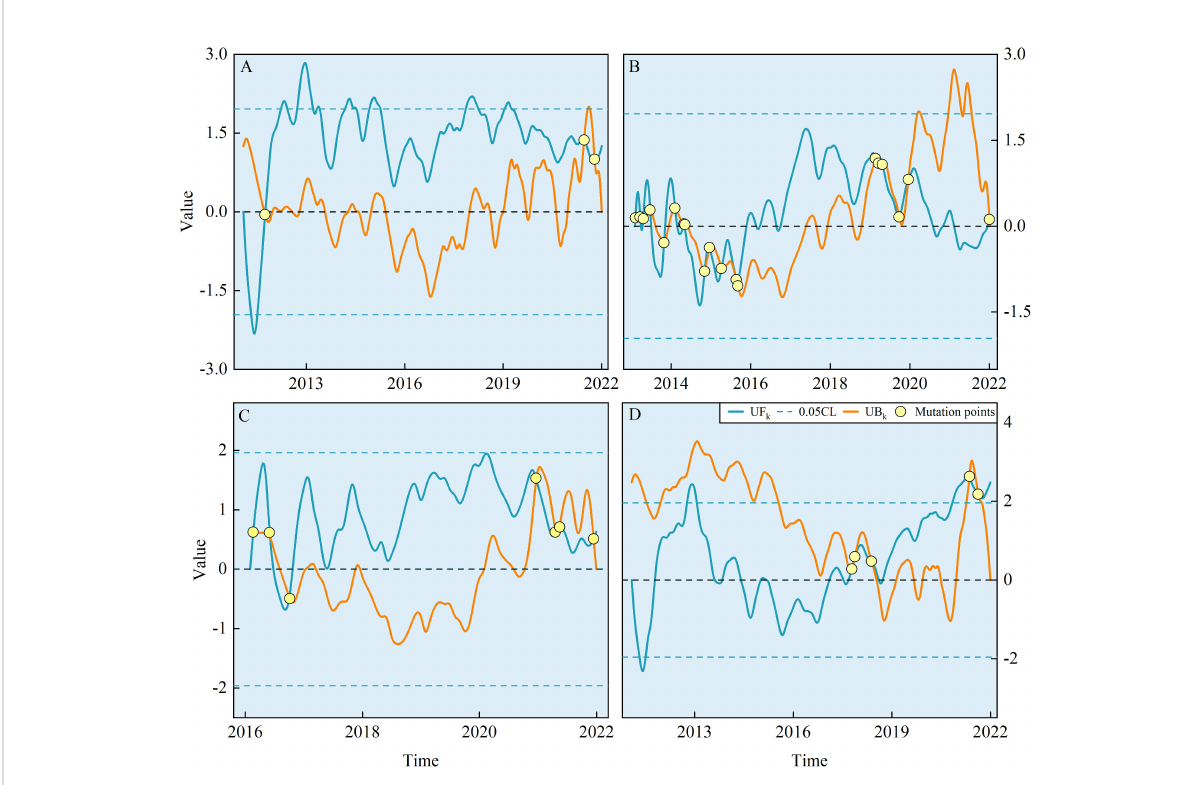
Sentinel-3 altimeter in SAR mode was better than the SARAL altimeter in the LRM mode when the same TR_ALES+ retracker was used, with an R improvement of 0.078, indicating that the SAR altimeter outperformed the LRM altimeter in the coastal region, which was consistent with the fi ndings of Fenoglio et al. (2021). Furthermore, the coastal water level estimating approach proposed in this paper did not obtain high-accuracy water level data, which may be due to the following reasons: on the one hand, the performance of altimeters in coastal areas decreased compared to the superior performance in the open ocean, as well demonstrated by Salameh et al. (2018). The results of Vignudelli et al. (2019) also showed that when the satellites were less than 6 km, the data availability decreased signi fi cantly. On the other hand, geophysical corrections such as dynamic atmospheric